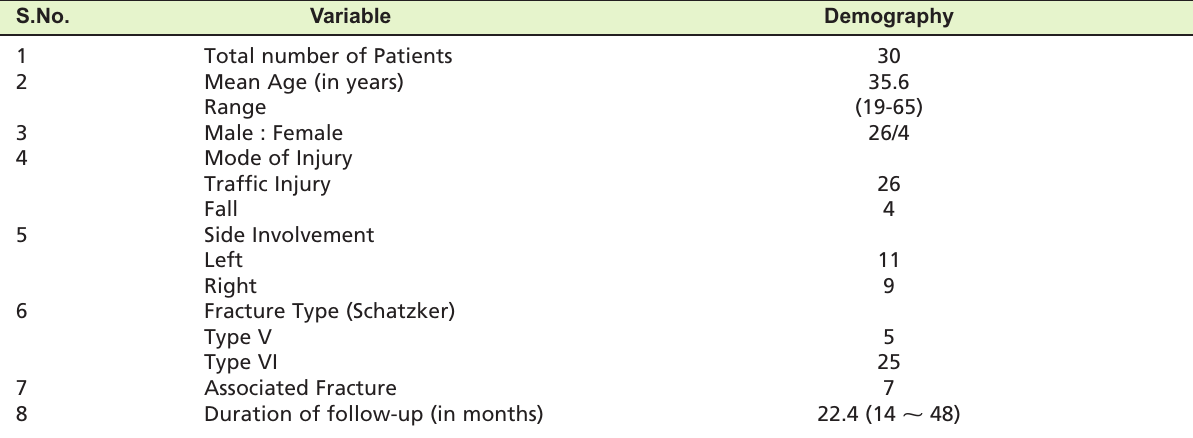
Perioperative and post-operative patient details Table II: